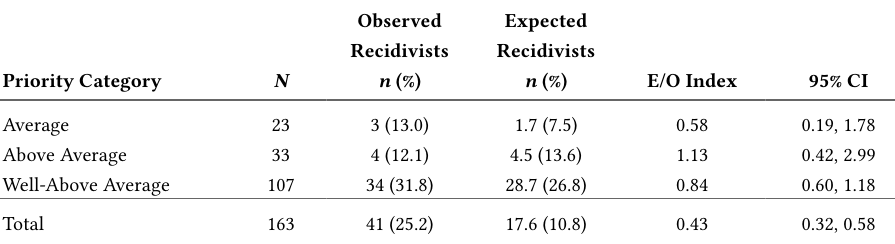
Sample 2: E/O Index and 95% CIs for Static-99R/Stable-2007 Priority Categories by Recidivism Type